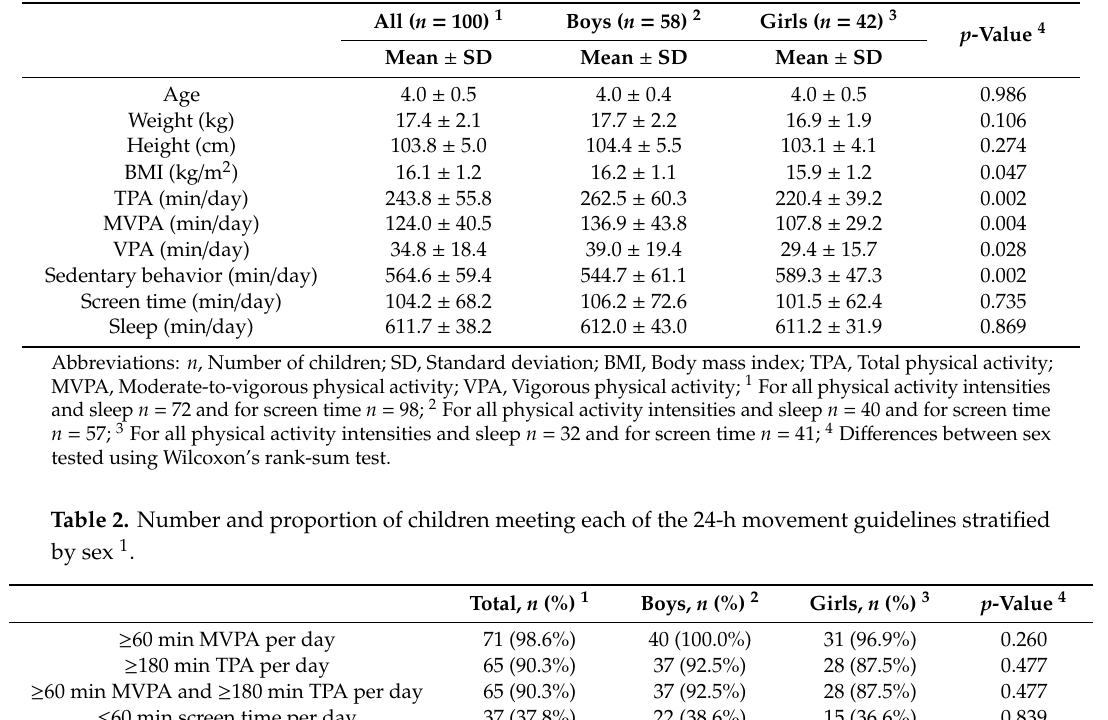
Table 1. Descriptive characteristics and time spent in movement behaviors of the participating children.